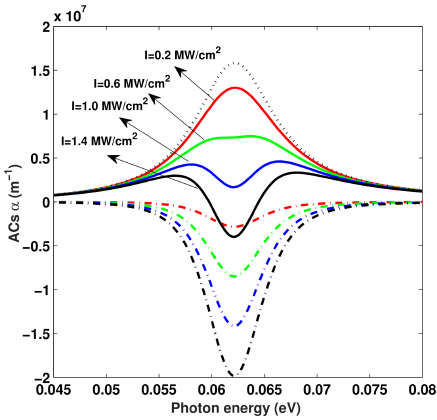
Figure 5. The resonance peak value of total optical absorption coefficients (OACs) as a function of incident optical intensity I with P = 0, T = 0, B = 0, and L = 8